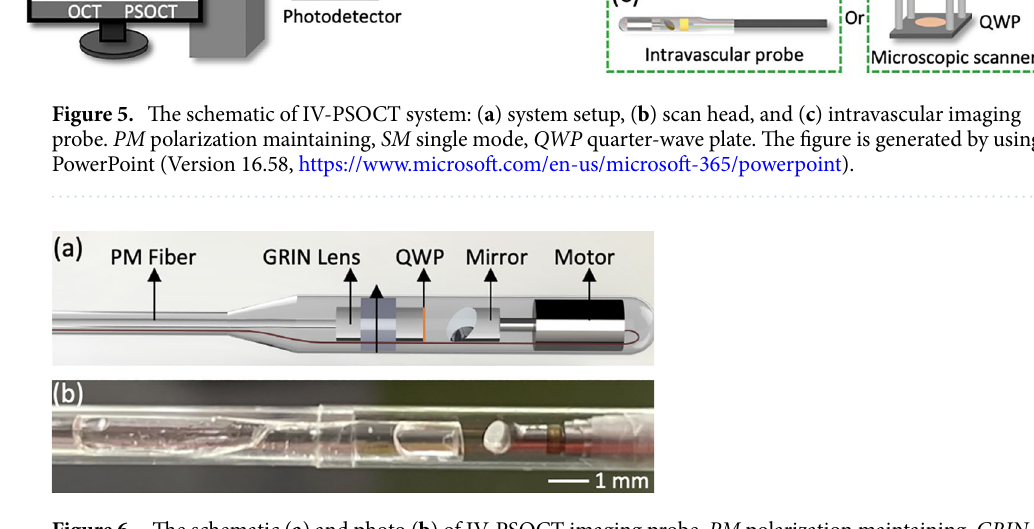
Figure 6. The schematic ( a ) and photo ( b ) of IV-PSOCT imaging probe. PM polarization maintaining, GRIN gradient index, QWP quarter-wave plate. Scale bar: 1 mm. Figure ( a ) is generated by using Solidworks (2020 SP3.0, https:// blogs. solid works. com/ tech/ 2020/ 08/ chang es- in- solid works- 2020- sp3.